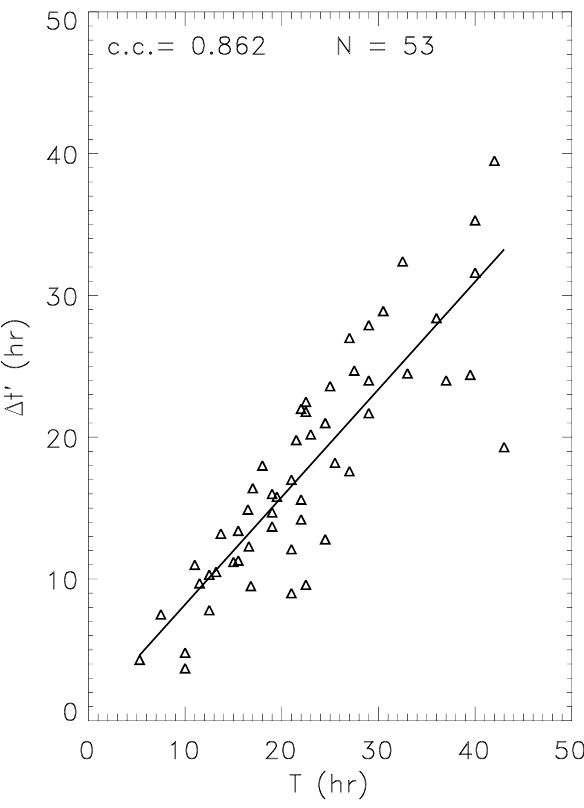
Fig. 8. A scatter diagram of 1t 0 vs. T showing a c.c. of 0.86.